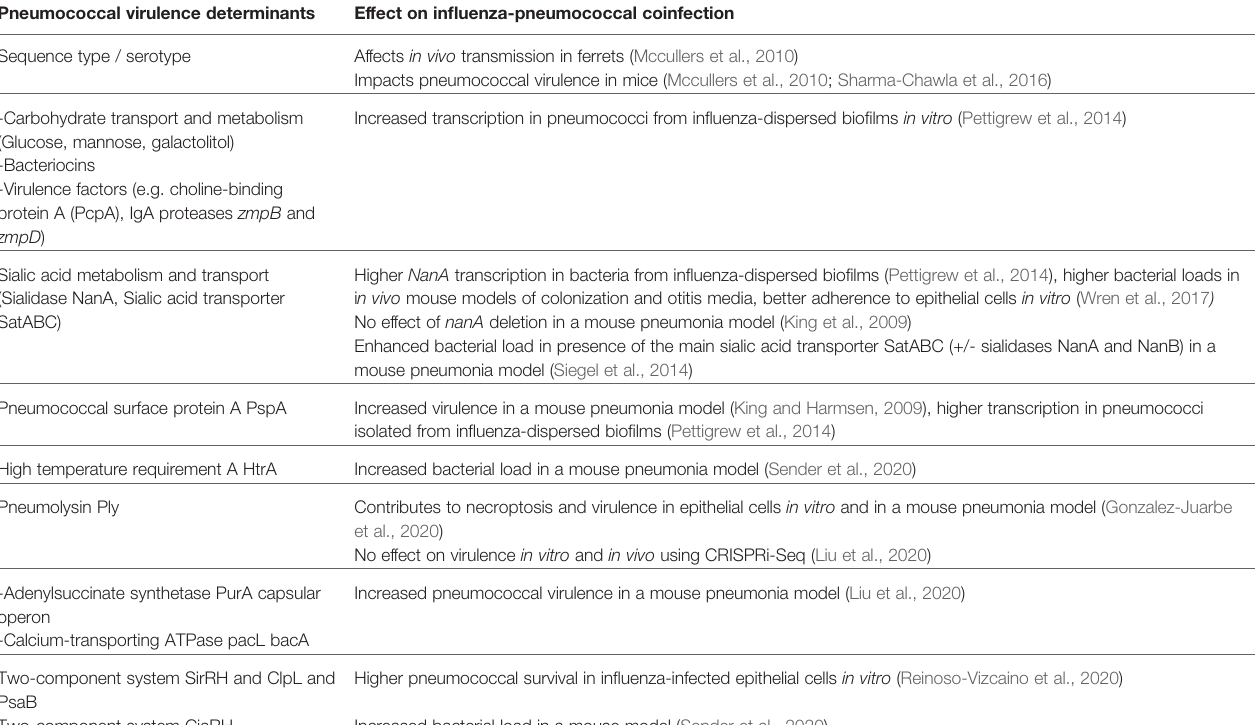
TABLE 1 | Pneumococcal virulence determinants and their effects on in fl uenza-pneumococcal coinfection. Pneumococcal virulence